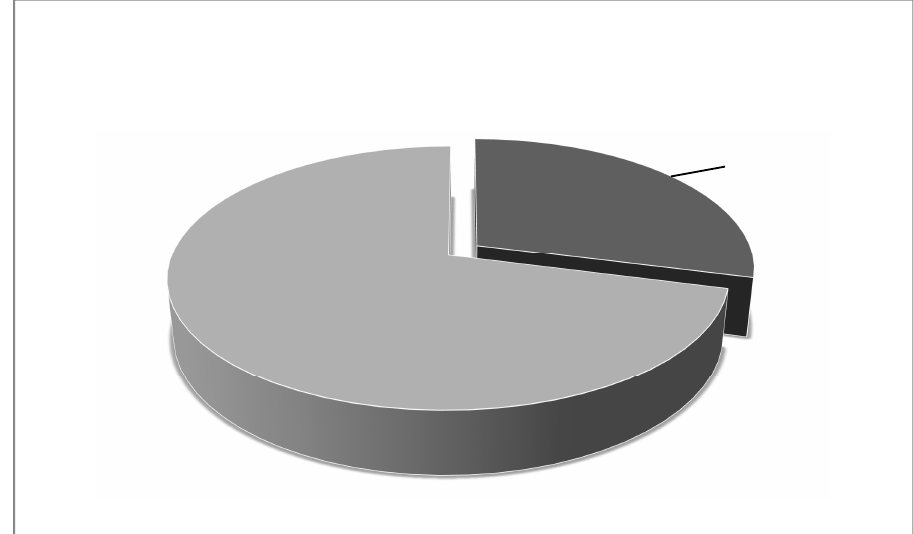
Figure 2 – Customer loyalty measurement in organizations in metallurgical industry (own